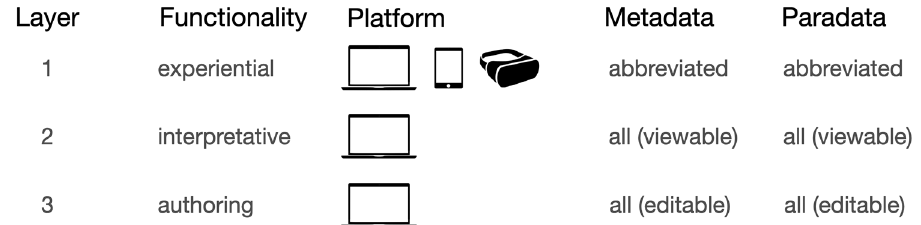
Figure 6: Multilayer user interface approach to our prototype 3D research